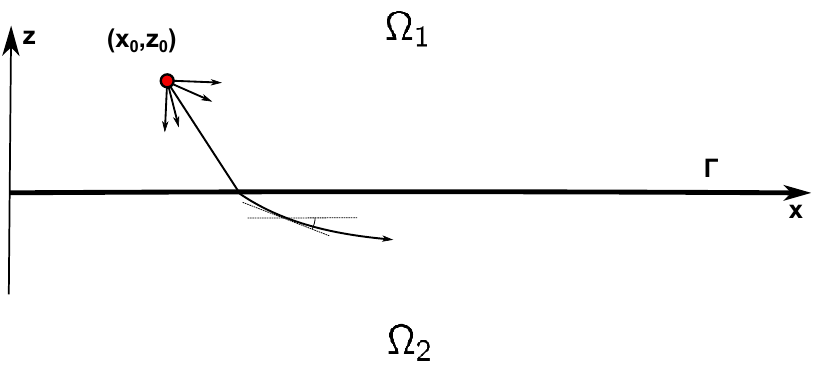
Figure 1. Geometry of the